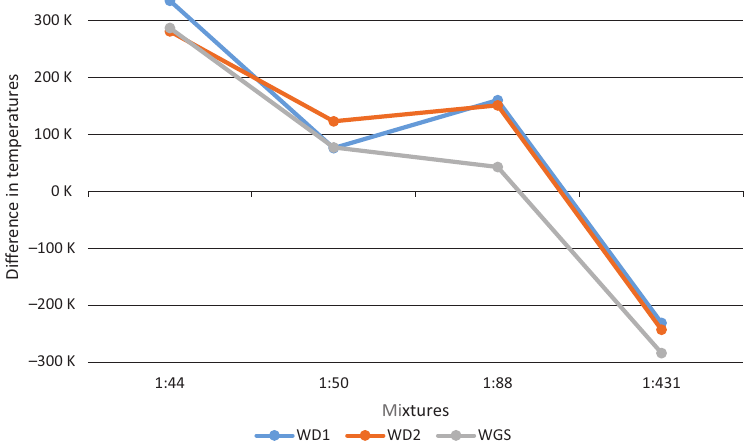
Figure 7. Temperature differences using different